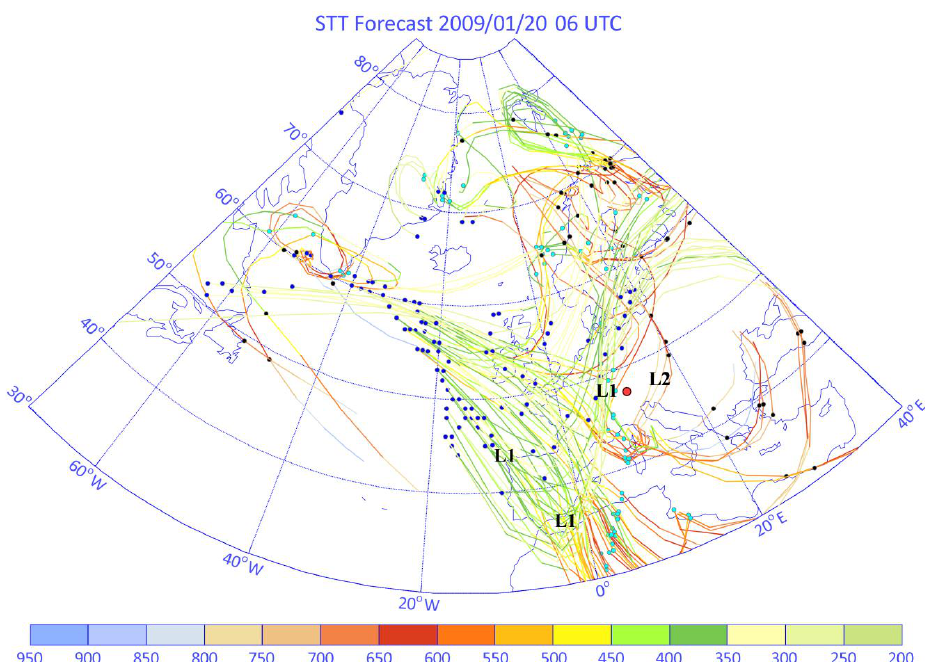
Figure 15. As Fig. 14, but initiated during a later phase of that intrusion, on 20 January 2009, at t o = 06 : 00UTC (07:00CET). Only intrusion S2 is left. L1 (marked three times during its approach) and L2 correspond to layers shown in Fig. 11 as explained in more detail in the text. Please, print figure two columns wide!